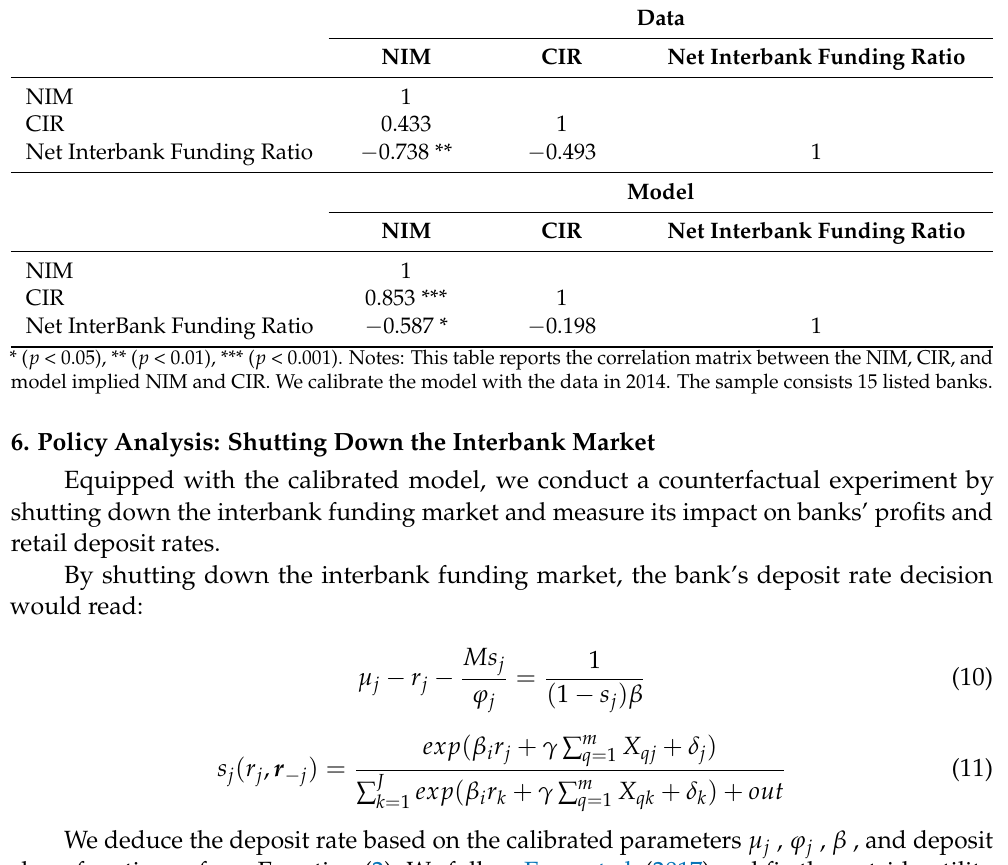
Table 4. Correlation